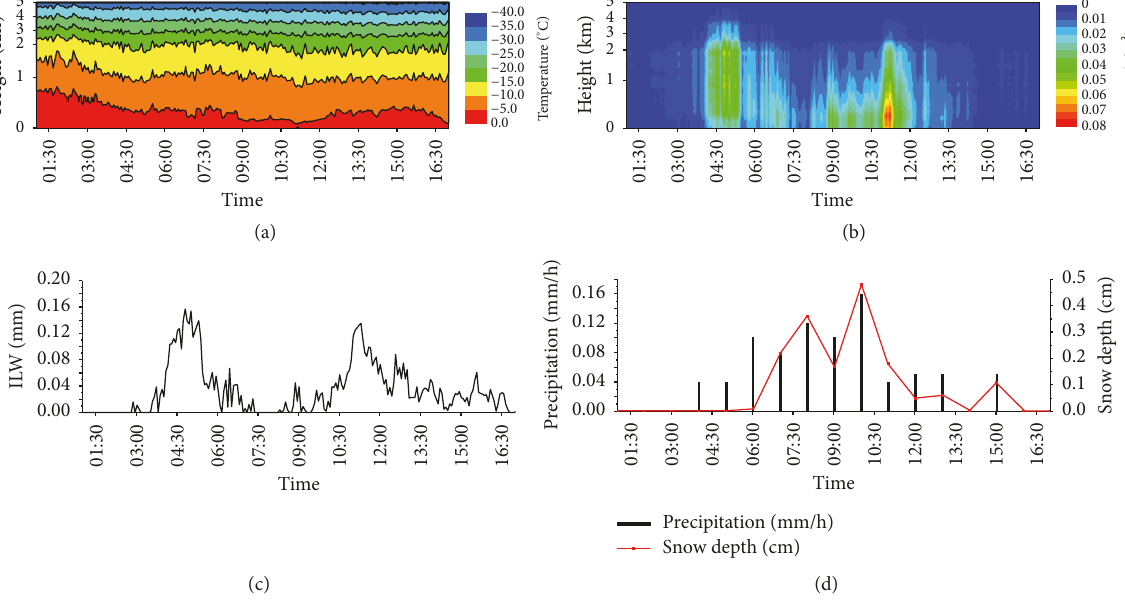
Figure 5: Evolution of temperature (a), LWC profile (b), integral liquid water (c), precipitation rate (black column), and snow depth (red line, (d)) at Yan Jiaping under typical low vortex (case 9) during snowfall. The height in 𝑦 -axis is above the